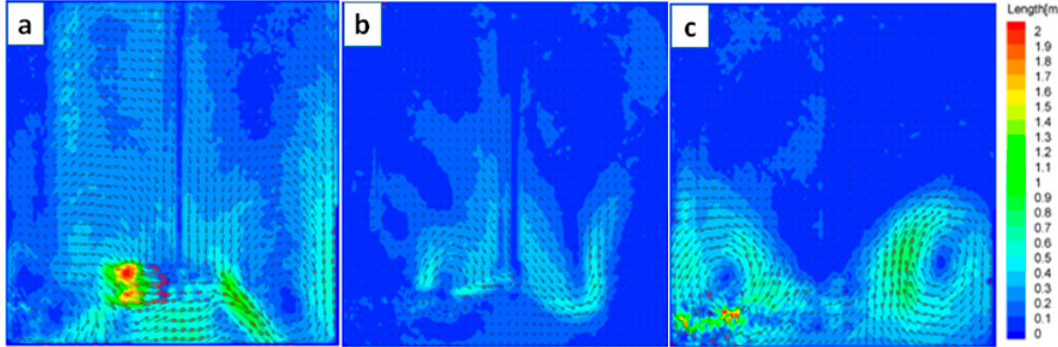
Figure 7. The velocity vector cloud diagrams of flow field distribution with different agitator types ( a —disc turbine impeller; b —Intermig impeller; and c —propelling propeller).